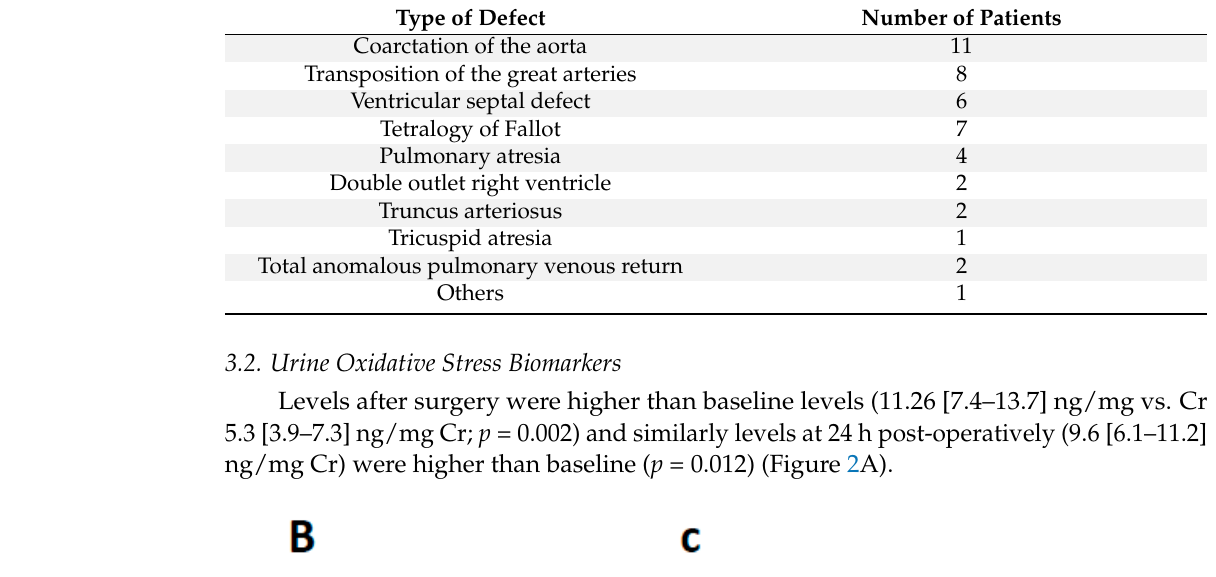
Table 2. Patient diagnoses.